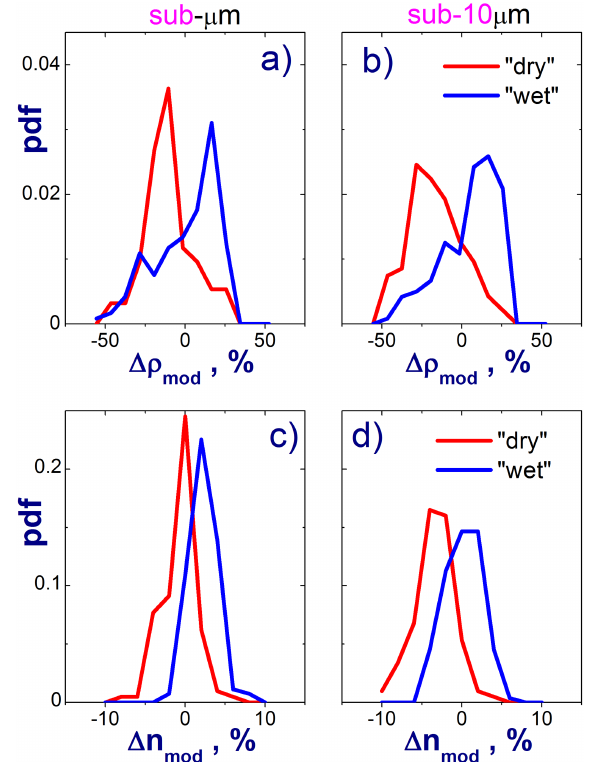
Figure 7. Probability distribution function (pdf) of the retrieval er- rors for the effective density ( 1ρ mod ) and the real refractive in- dex ( 1n mod ) obtained for the sub-micron (left column) and sub- 10-micron (right column) particles. Red and blue colors define the retrieval errors obtained for the “dry” and “wet” conditions, respec- tively. Note that different scales are used for 1ρ mod (top row) and 1n mod (bottom row). Factors associated with particle diameter and humidity (see text for details) are the main sources of the observed differences between the pdfs (red versus blue